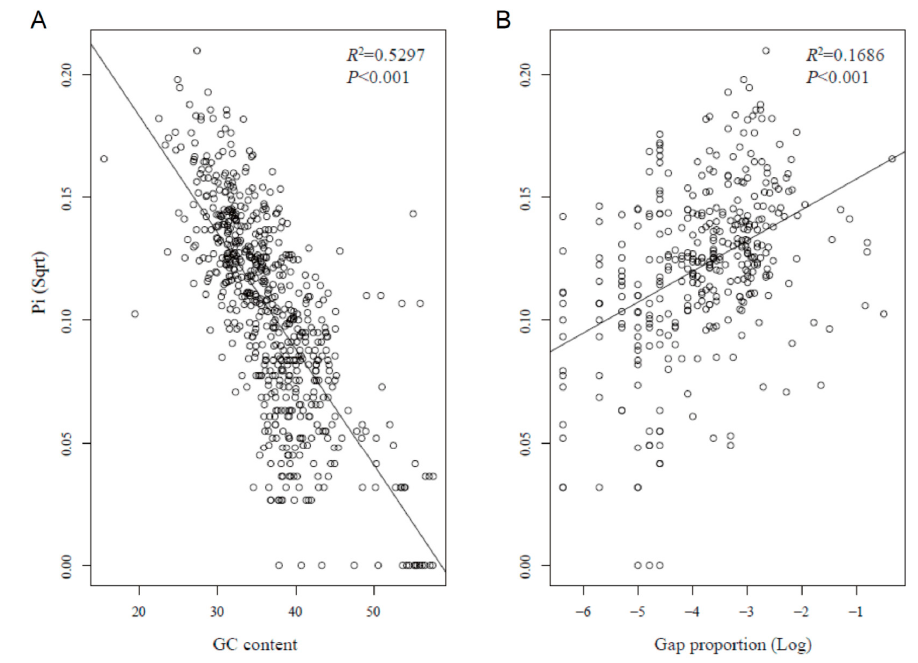
Figure 4. GC content and gap proportion are correlated with Pi . ( A ) Scatter plot showing a significant negative correlation ( p < 0.001) between GC content and Pi (Sqrt). ( B ) Scatter plot showing a significant positive correlation ( p < 0.001) between gap (indels) proportion and Pi (Sqrt) in the five Pogostemon